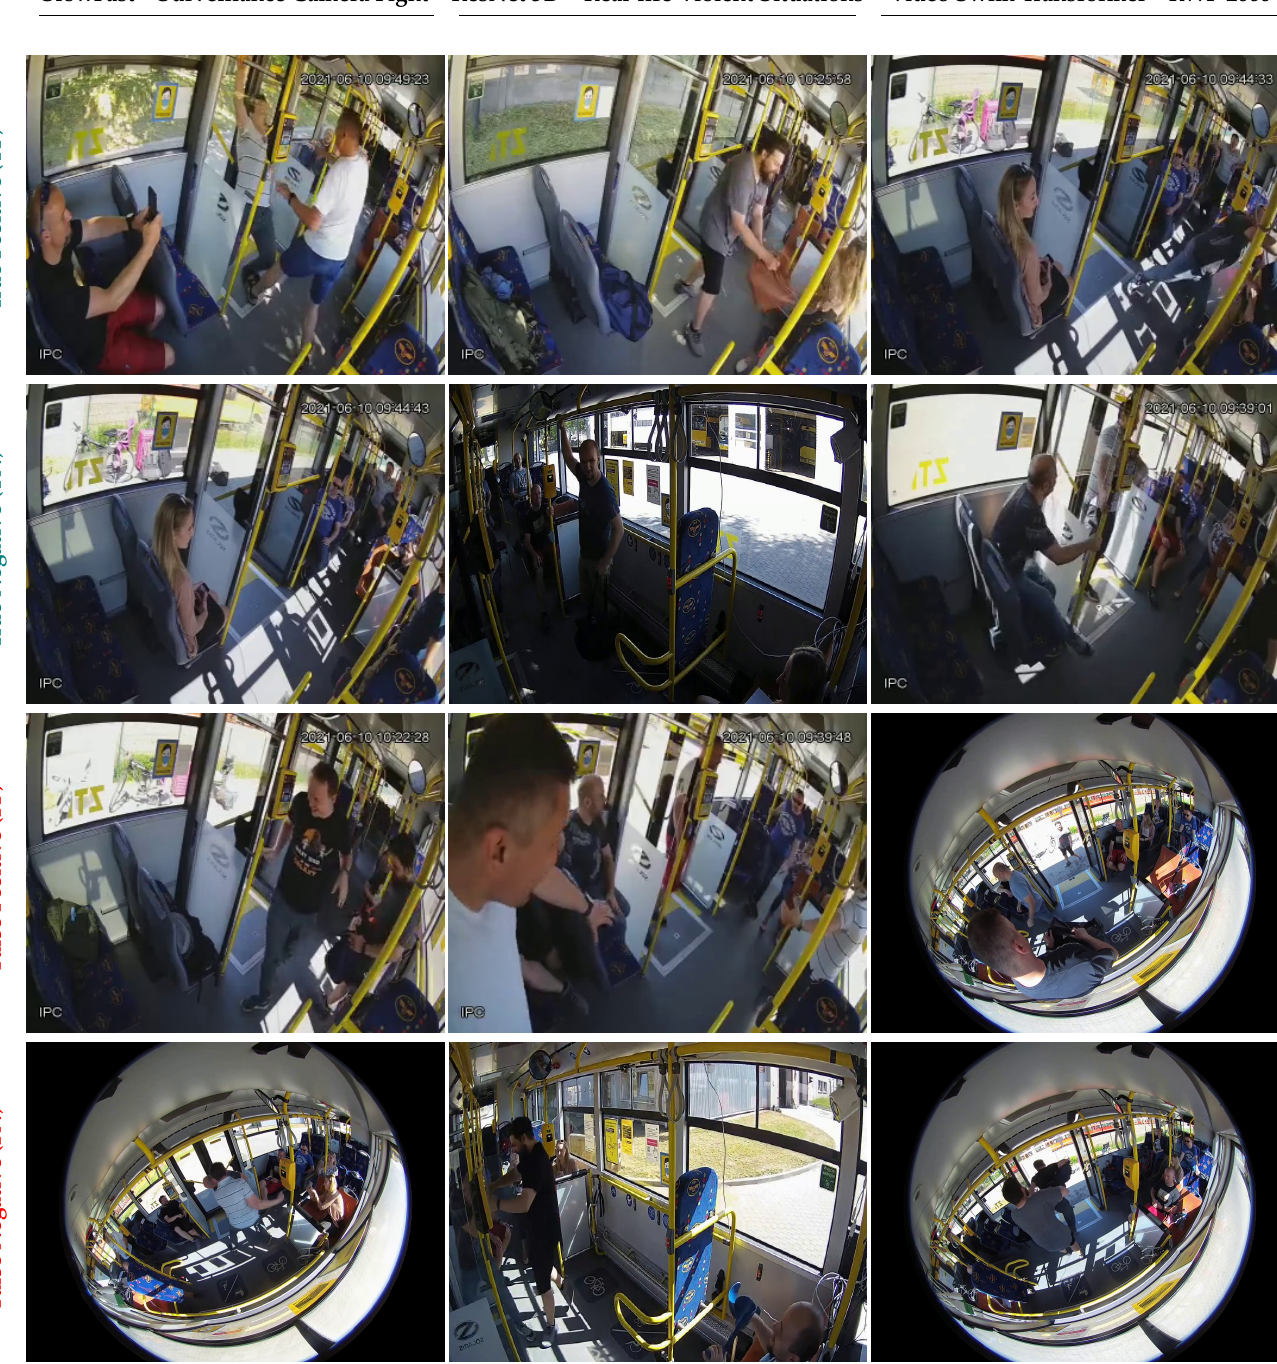
Figure 3. Some samples of predictions concerning the three most performing pairs models/pre- training datasets, i.e., SlowFast/Surveillance Camera Fight, ResNet 3D/Real-life Violent Situations, and Video Swim Transformer/RWF-2000 (one for each column). In the four rows, we report true positives, true negatives, false positives, and false